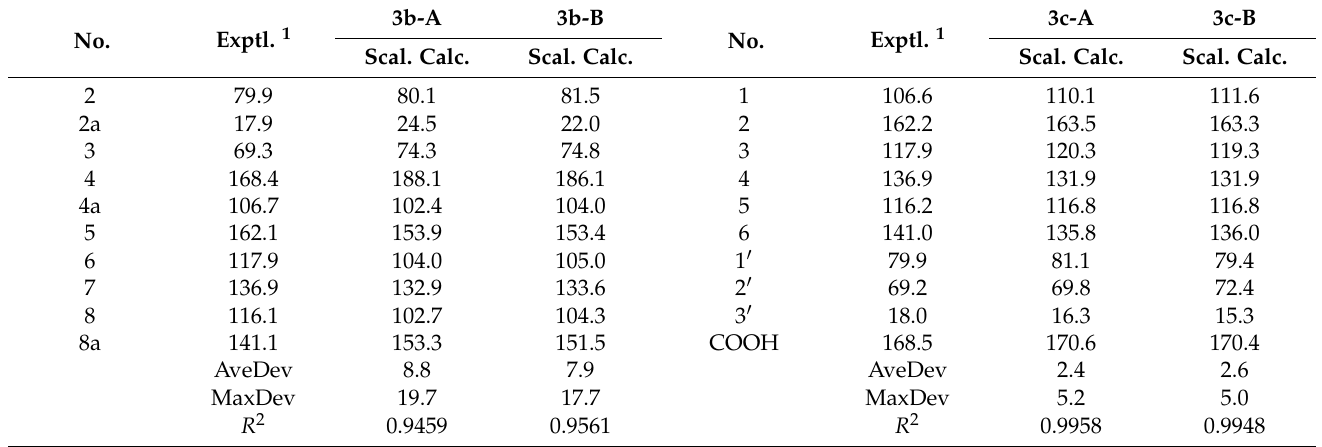
Table 3. Experimental and calculated 13 C NMR chemical shifts of 3b and 3c